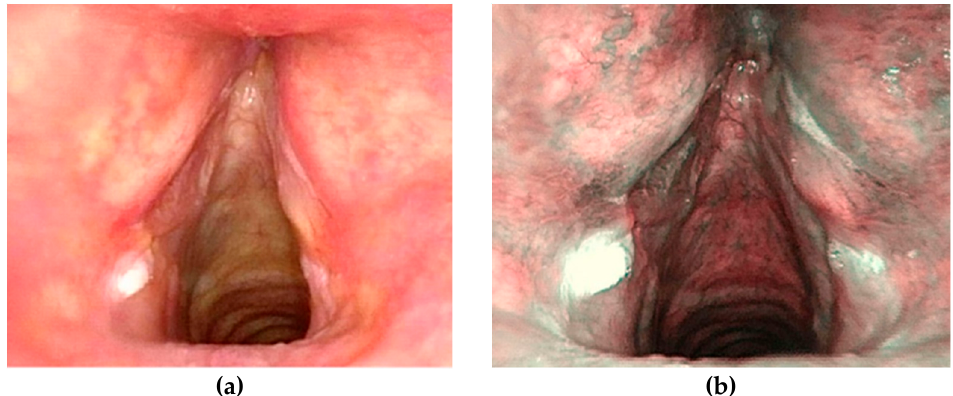
Figure 1. Patient, 63 years old with hyperkeratosic lesions, stable at three year close follow up. WLE endoscopy ( a ), NBI examination ( b ) .